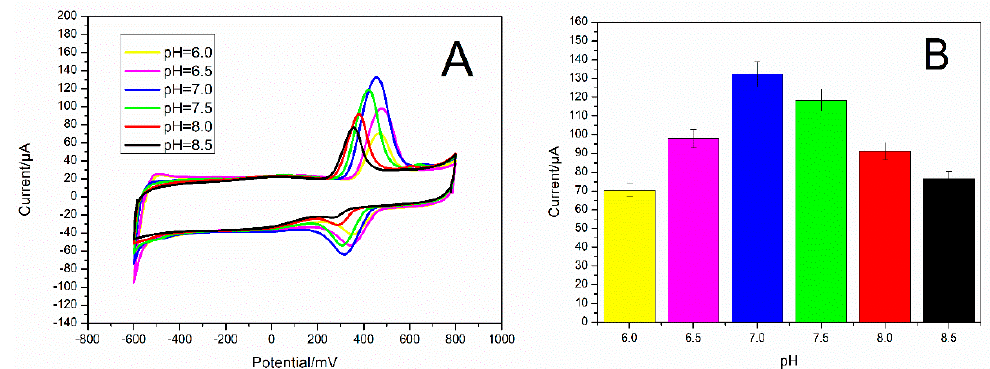
Figure 3. ( A ) CV responses to 0.9 mM uric acid in various pH conditions (pH = 6.0, 6.5, 7.0, 7.5, 8.0, and 8.5) with UOx/BSA/BLG-MWCNTs-PtNPs/GCE (buffer pH = 7.0, the scanning voltage range − 600~800 mV), trends are shown in a histogram ( B